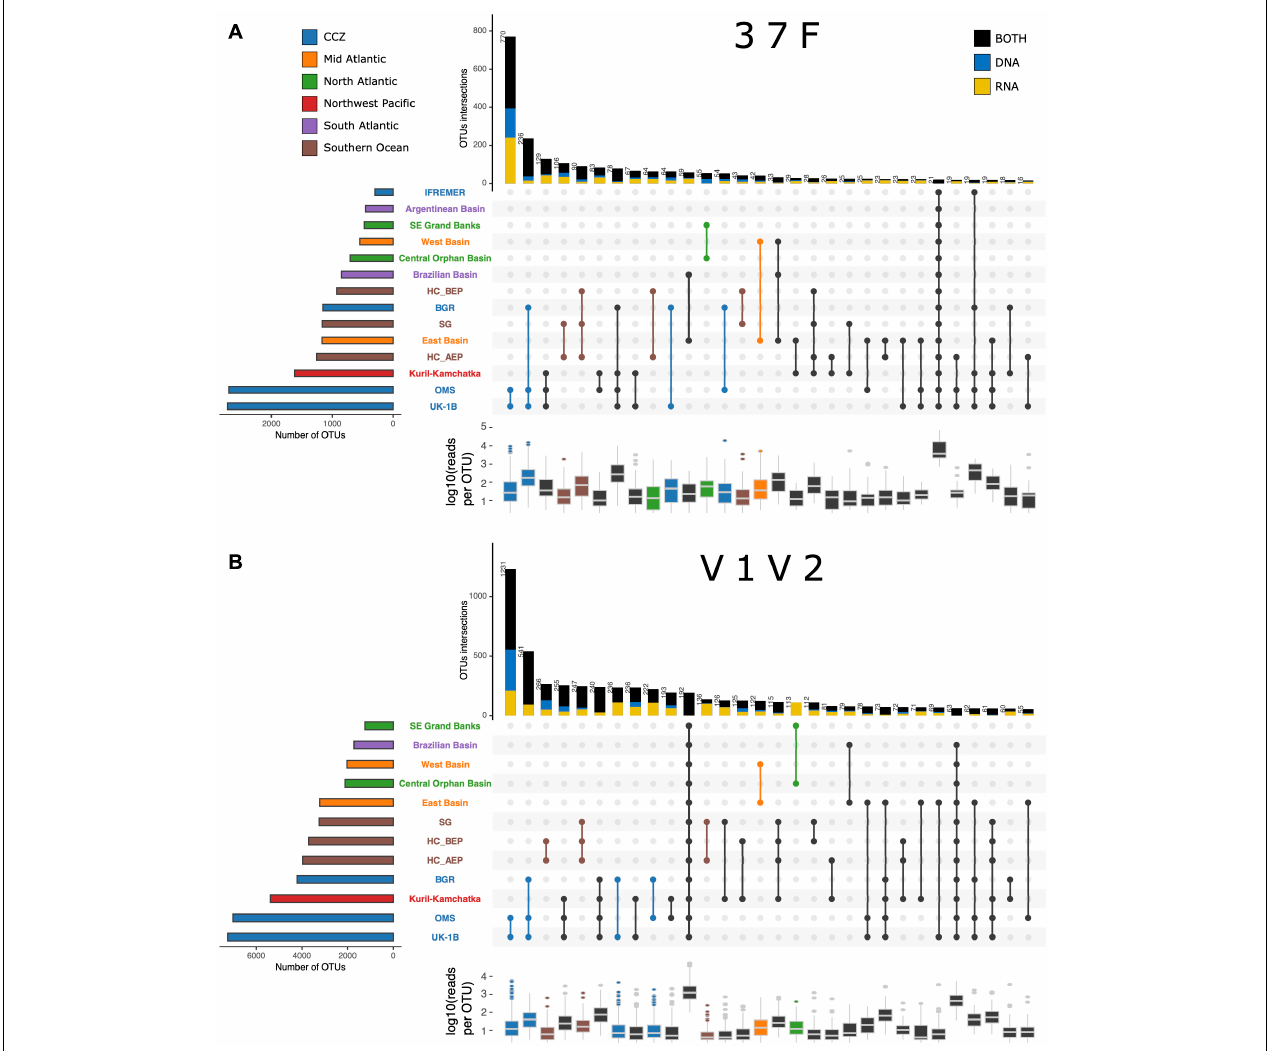
FIGURE 5 | Diversity specific to region intersections. Number and read frequencies for (A) the 37F (benthic) and (B) the V1V2 (all taxa) OTUs shared at different intersections of regions (matrix rows). Only the 30 intersections that are the largest in terms of numbers of OTUs are shown, and ordered by decreasing OTU numbers. The bars on the top panel indicate the number of OTUs in the intersection denoted by the connected dots on the middle panel. Bars are colored according to molecule (blue: DNA; yellow: RNA; black: both). The bars on the left panel indicate the total number of OTUs in each area (or station), while the box plots on the bottom panel indicate the distribution of reads in each OTU per